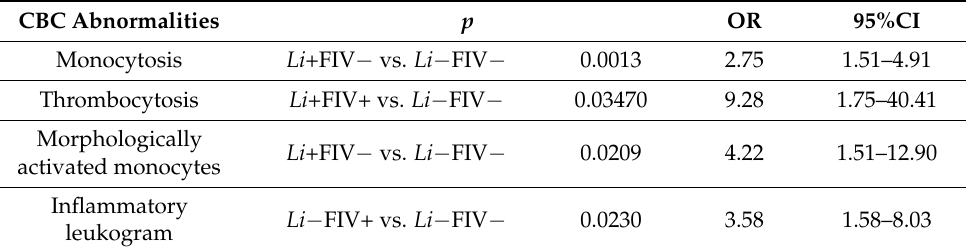
concerning the CBC